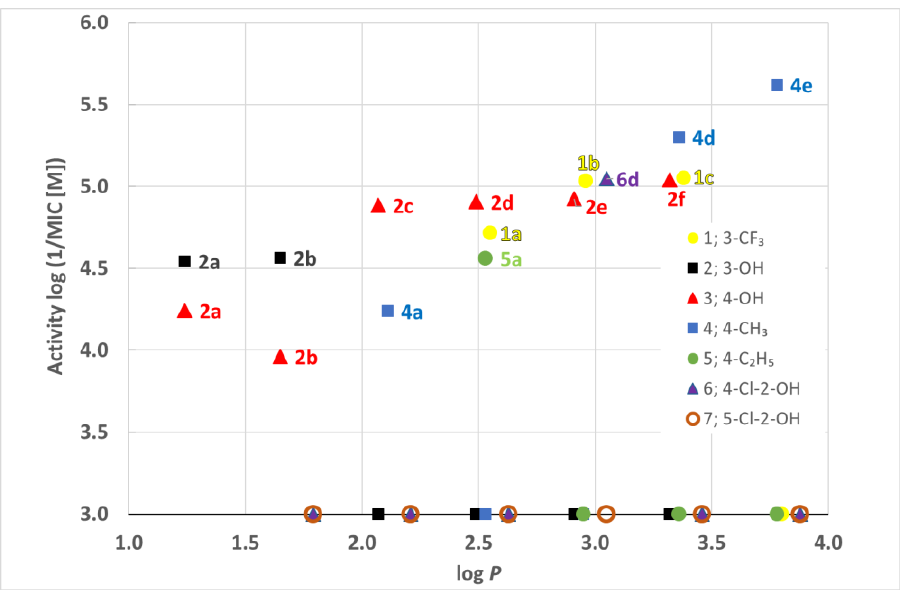
Figure 2. Plot of antimycobacterial activity against Mtb H37Ra expressed as log (1/MIC [M]) and calculated lipophilicity log P . Inactive compounds had an arbitrary value of activity of 3.0.